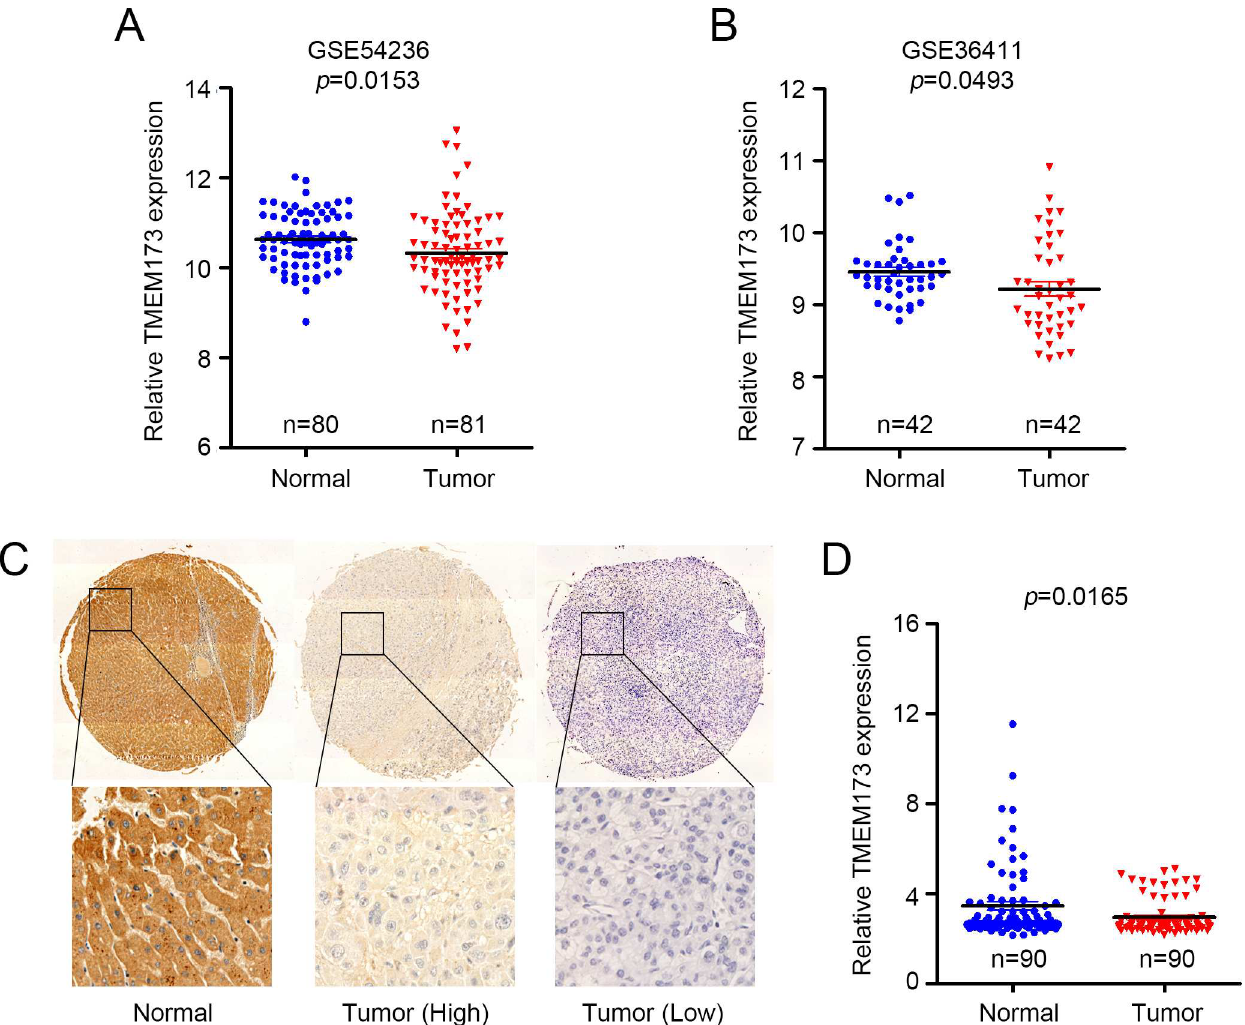
Fig 1. The expression patterns of TMEM173 in HCC tissues. (A-B) Relative expression of TMEM173 mRNA in HCC and normal liver tissues in GSE54236 (A) and GSE36411 (B). (C) Representative IHC staining images of TMEM173 and its regionalmagnificationin HCC tissues and non-tumor tissues. Scale bar = 200 μ m. (D) IHC score of TMEM173 expression in HCC tissues and non-tumor tissues.